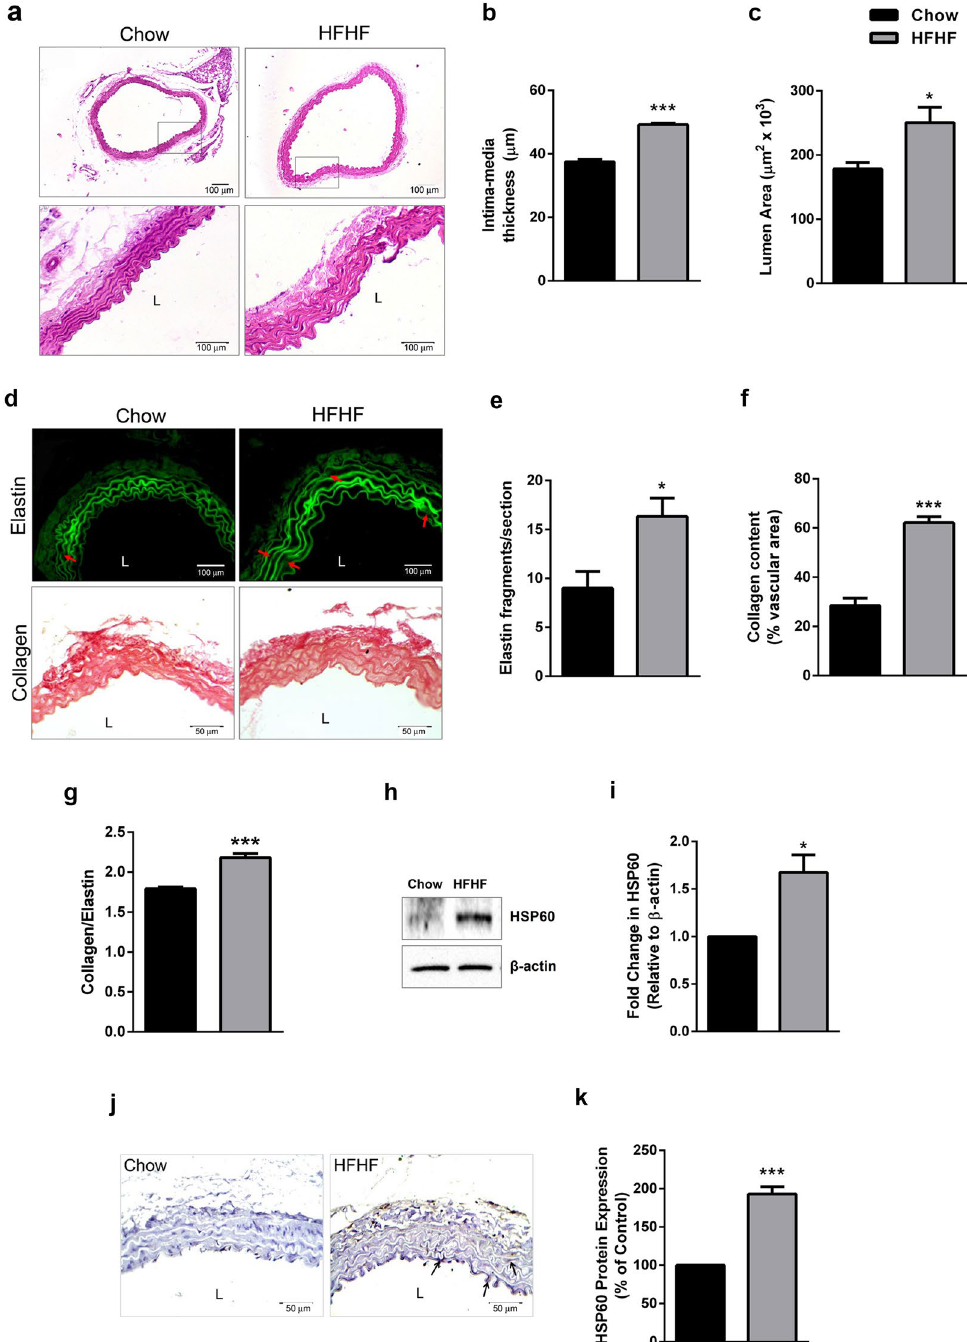
Figure 2. Pro-atherogenic remodelling and HSP60 expression in thoracic aorta of HFHF diet fed mice. ( a ) Histological analysis of thoracic aortas stained with H × E (100× and 400×) were subjected to quantification of ( b ) Intima-media thickness (IMT) (n = 3; Scale bar = 100 µm) and ( c ) lumen area (n = 3). The sections were also subjected to ( d ) elastin autofluorescence analysis (upper lane, red arrows indicate elastin breaks; Scale bar = 100 µm) and collagen staining by picrosirius red (lower lane; Scale bar = 50 µm). The graphs represents ( e ) elastin fragmentation (n = 3), ( f ) collagen content (n = 5 for control, n = 4 for HFHF) and ( g ) collagen-to- elastin ratio (n = 4). The expression of HSP60 was analysed by ( h ) western blotting followed by ( i ) densitometry (n = 3) and ( j ) immunohistochemistry (Scale bar = 50 µm; arrows indicate HSP60 + stained areas) followed by ( k ) quantification (n = 3) by Image J. Data were expressed as Mean ± SEM. *p < 0.05, ***p < 0.001 vs Chow diet fed mice, unpaired two-tailed Student’s t-test. L